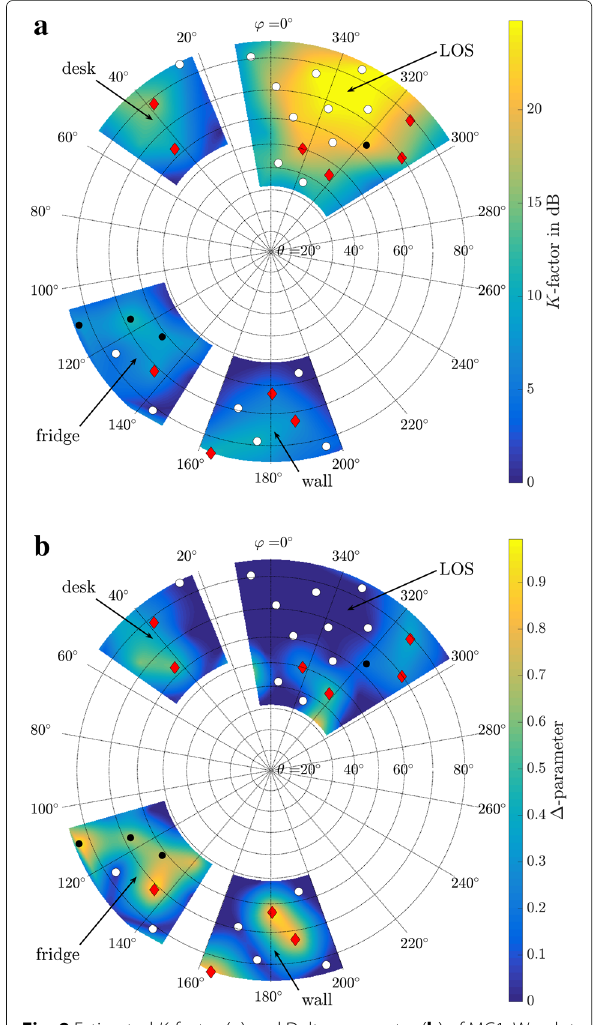
Fig. 8 Estimated K -factor ( a ) and Delta-parameter ( b ) of MC1. We plot the K -factor estimate of the selected hypothesis. The K -factor behaves analogously to the RX power. At LOS, the K -factor is far above 20dB. The desk reflection has a surprisingly high K -factor of about 15dB. Other reflections have K -factors of approximately 10dB. The (cid:7) -parameter for reflections tends to be close to 1. Markers have the same meaning as in Fig. 7